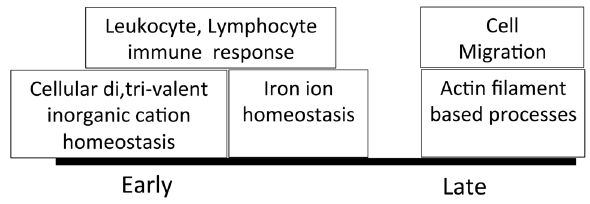
Figure 2. Biological processes represented by 175 proteins that are differentially expressed when late-phase survivors are compared to early-phase survivors. GO enrichment analysis was performed using the universe of identified BALF proteins as a background. A Functional Annotation Clustering tool was used to group related biological processes. Annotation clusters with an enrichment score . 1.3 are shown. In the functional annotation- clustering tool, an enrichment score of 1.3 that corresponds to a non- log scale p-value of 0.05 was used as the cutoff for significance. doi:10.1371/journal.pone.0109713.g002 and participated in biological processes listed in Table 3. BALF levels of Plasminogen, Factor 12, Antithrombin and Cerulopasmin